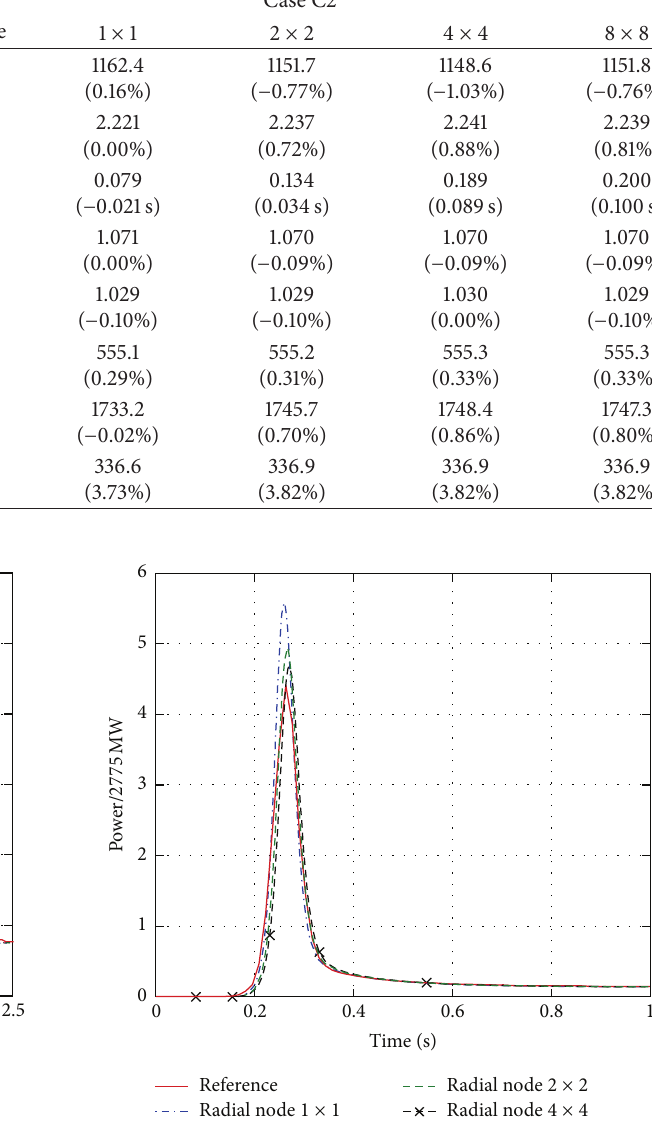
Table 4. For the same case C2, the maximum fuel